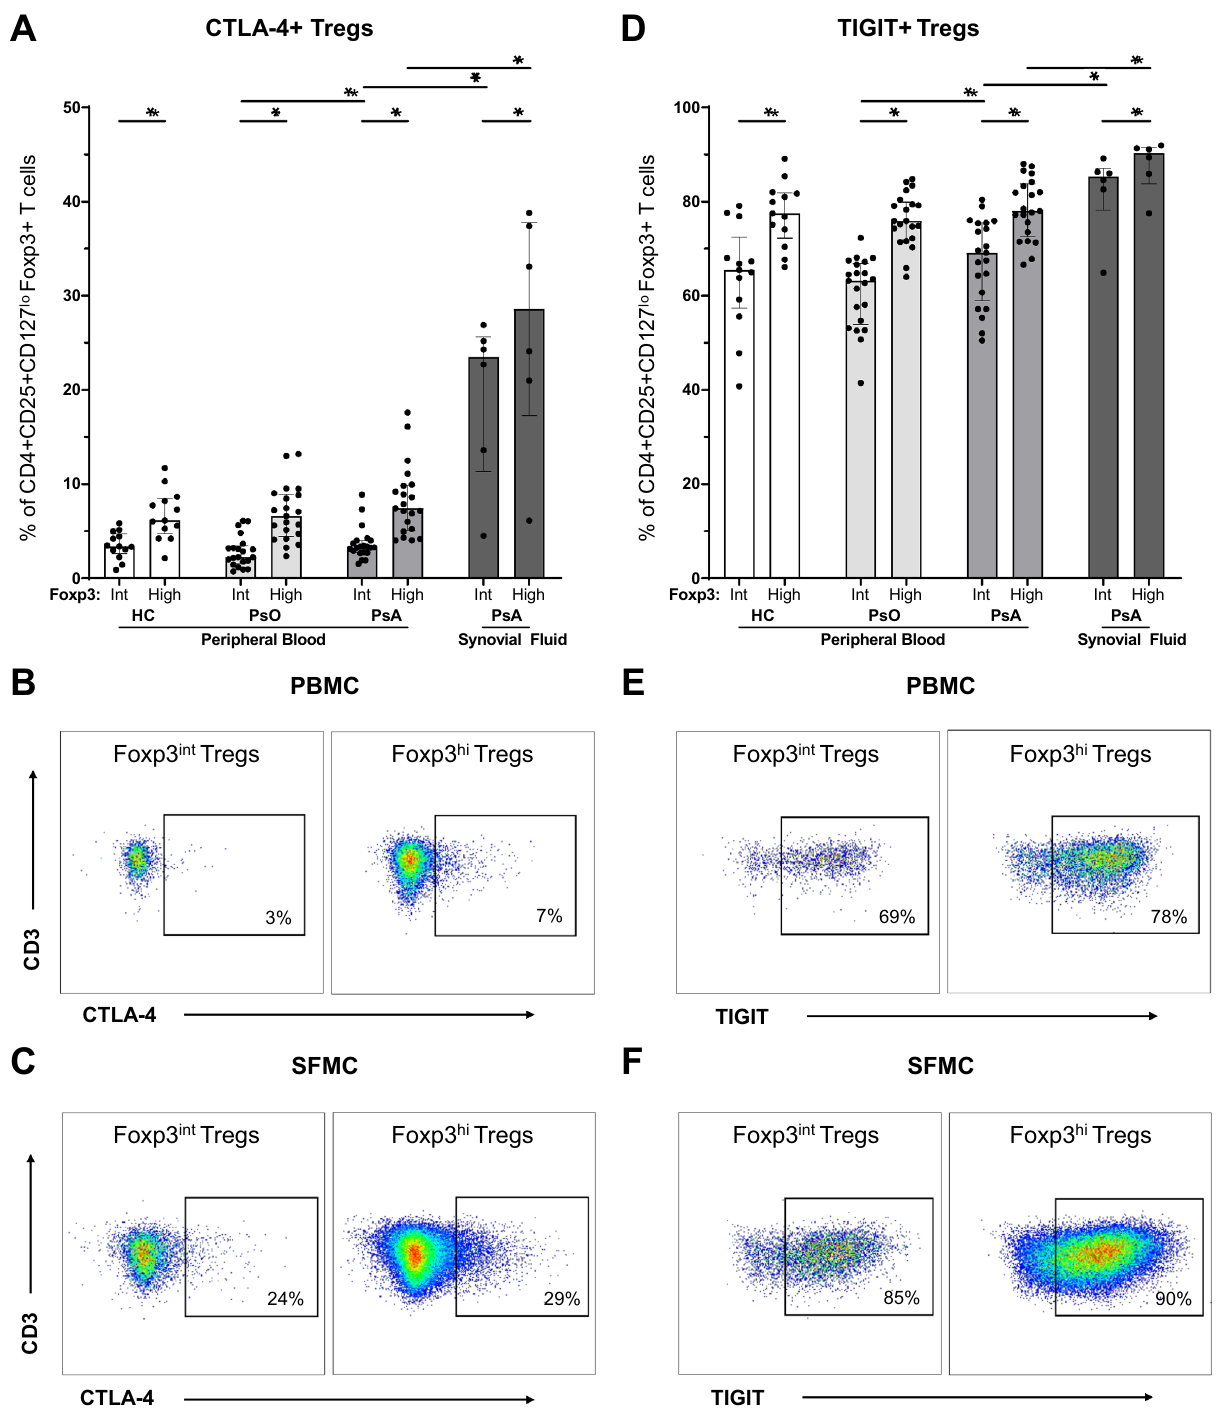
Figure 4. High expression of key regulatory immune receptors by intra-articular Tregs in PsA. Flow cytometry analysis of CD4 + CD25 + CD127 lo Foxp3 + Tregs derived from peripheral blood of HC (n = 13), psoriasis patients (n = 21) and PsA patients (n = 21), and from synovial fluid of PsA patients (n = 6). Bar graphs: symbols represent individual subjects; bars show median with interquartile range; * P value < 0.05 (synovial fluid only compared with PsA peripheral blood). Dot plots: percentages in PBMC plots represent median of PB-derived Tregs in PsA; percentages in SFMC plots represent median of SF-derived Tregs. ( A ) Proportion of CTLA-4 + Foxp3 int and CTLA-4 + Foxp3 hi Tregs. ( B,C ) Representative flow cytometry plots to identify CTLA-4 + Foxp3 int and -Foxp3 hi Tregs derived from peripheral blood ( B ) and synovial fluid ( C ). ( D ) Proportions of TIGIT + Foxp3 int and TIGIT + Foxp3 hi Tregs. ( E,F ) Representative flow cytometry plots to identify TIGIT + Foxp3 int and -Foxp3 hi Tregs derived from peripheral blood ( E ) and synovial fluid ( F ). CTLA-4: cytotoxic T-lymphocyte-associated protein 4 (CD152); Foxp3 int / -hi : forkhead box P3 expression intermediate / high; HC: healthy control; PBMC: peripheral blood mononuclear cells; PsA: psoriatic arthritis; PsO: psoriasis; SFMC: synovial fluid mononuclear cells; TIGIT: T cell immunoreceptor with Ig and ITIM domains; Tregs: T regulatory